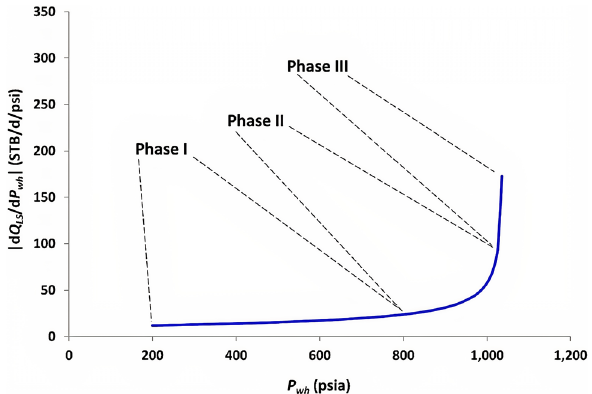
Fig. 8 Stability plot for well A, after applying the new procedure to the performance data generated from the PIPESIM model